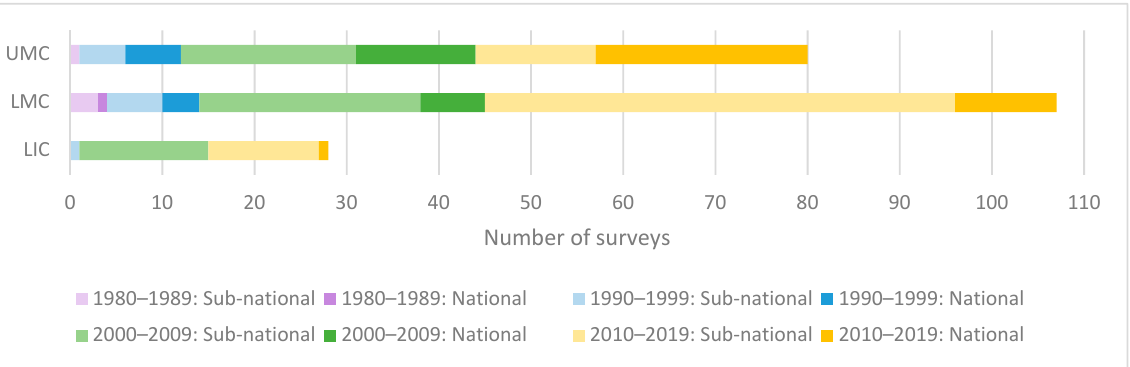
Figure 7. Number of national and sub-national dietary surveys conducted in LMICs from 1980 to 2019 by decade and by country income level, excluding longitudinal surveys. Country income groups reflect the World Bank classification for 2021. Data shown reflect the situation as of May 2022. LIC = low-income countries; LMC = lower-middle-income countries; UMC = upper-middle-income countries.